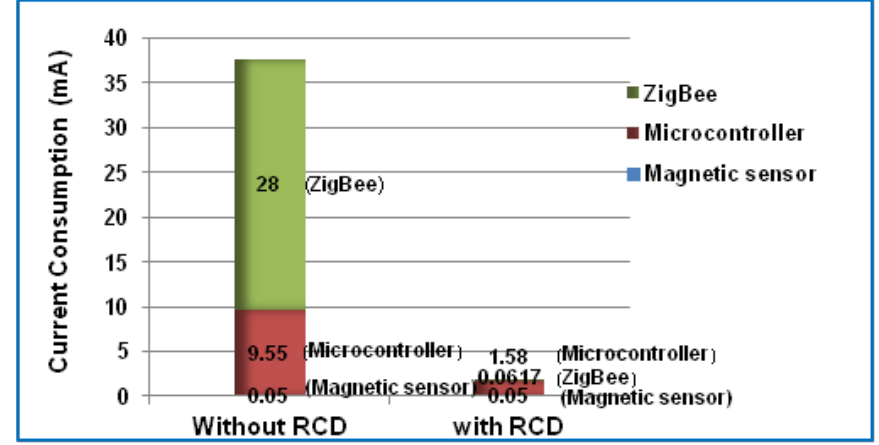
Figure 7. The current consumption of components of the sensor node with and without applying the RCD algorithm.